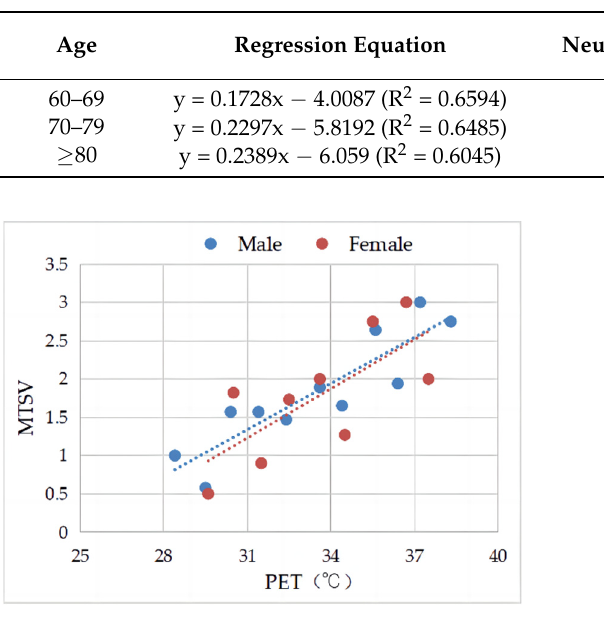
Figure 9. Correlation between MTSV and PET in elderly of different genders. Table 6. Neutral PET and neutral PET range in elderly by